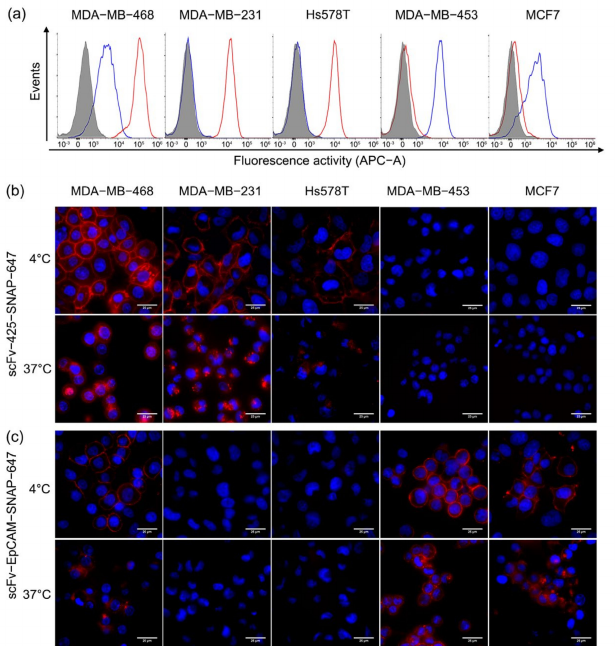
Figure 2. Specific binding and internalization of scFv-SNAP fusion proteins. ( a ) EGFR and EpCAM expression and specific targeting of Alexa Fluor ® 647-labeled scFv-SNAP fusion proteins were measured by flow cytometry. The red and blue curves represent cells treated with scFv-425-SNAP-647 or scfv-EpCAM-SNAP-647, respectively and the filled gray curve represents untreated cells. ( b , c ) The binding and internalization of scFv-425-SNAP-647 and scFv-EpCAM-SNAP-647 was visualized by fluorescence microscope. The binding process was carried out at 4 ◦ C, while the internalization process was carried out at 37 ◦ C. The red and blue signal represent Alexa Fluor ® 647-labeled scFv- SNAP fusion proteins and Hoechst 33,342 nuclear counterstain,